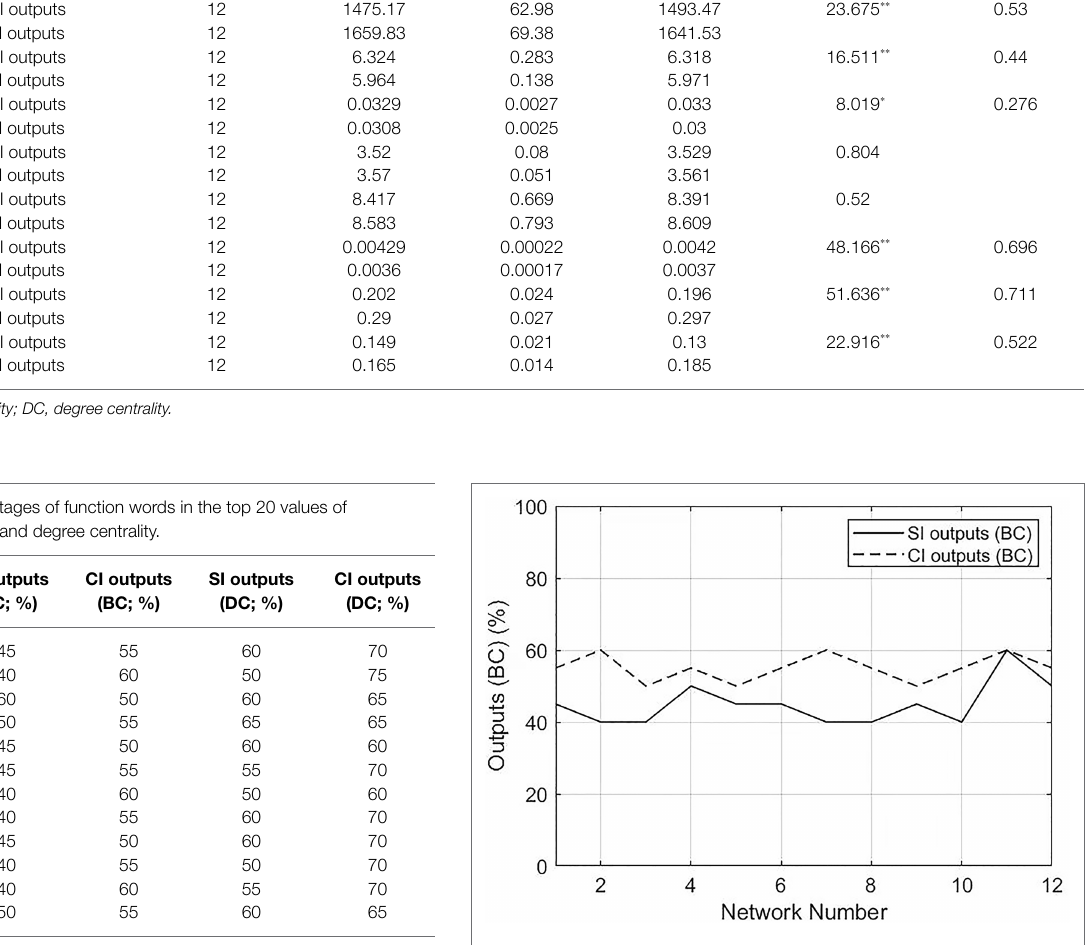
FIGURE 6 | Distributions of percentages of function words in the top 20 values between SI and CI outputs. BC, betweenness